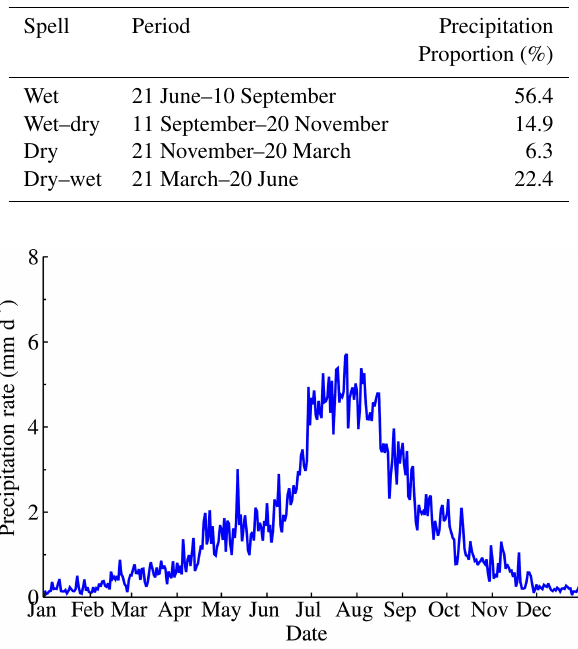
Table 3. Dates of dry and wet spells and their associated proportions of annual total precipitation in northern China. Both Wet–Dry and Dry–Wet represent corresponding transition spells.